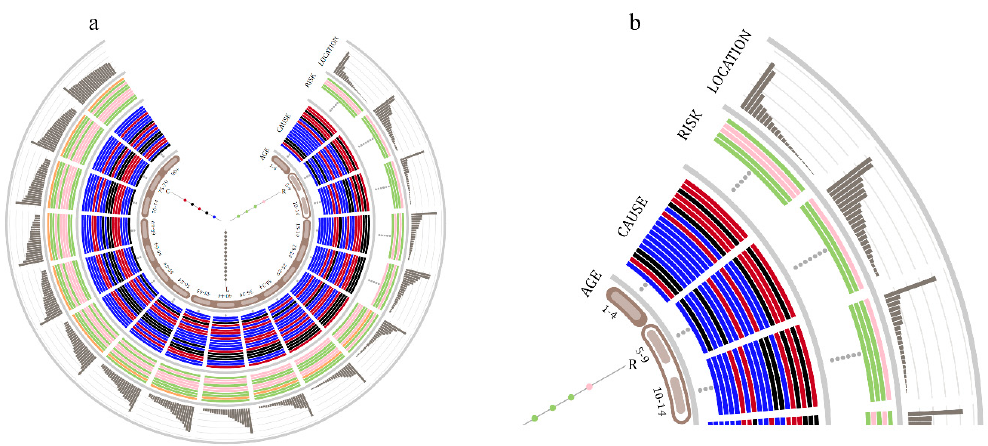
Figure 3. ( a ) Overall visualization for demography; ( b ) enlarged partial demography visualization.